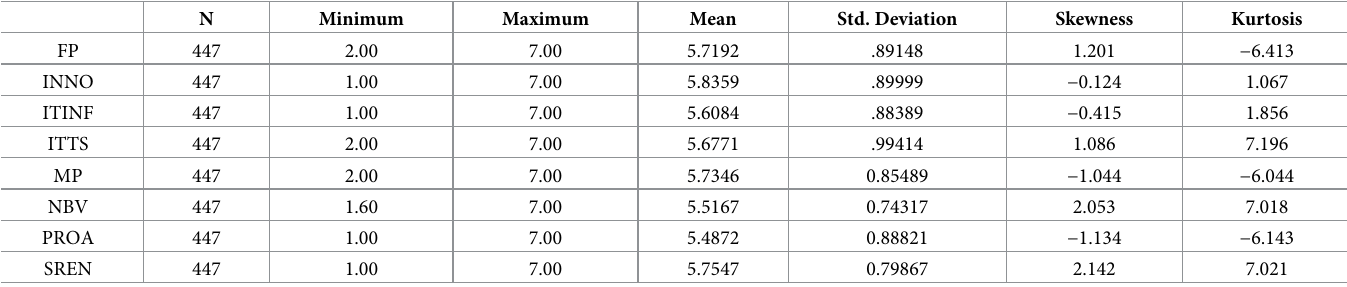
Table 2. The descriptive